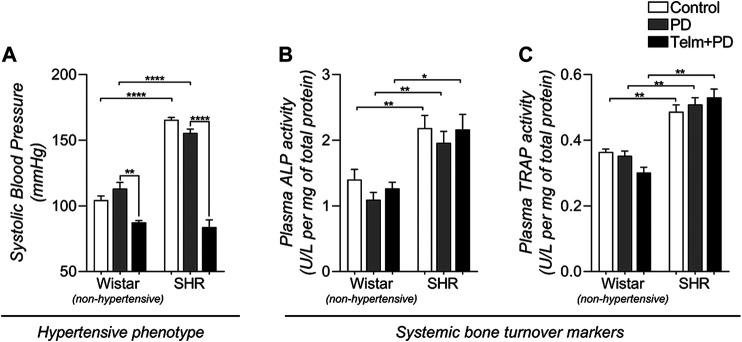
Systolic blood pressure (SBP) and systemic bone turnover biochemical markers of Wistar (non-hypertensive) and SHR with PD 15 days, treated with telmisartan. SBP (A) measured by tail plethysmography, and plasma activity of alkaline phosphatase, ALP (B) and tartrate-resistant acid phosphatase, TRAP (C) determined by enzymatic colorimetric methods. All graphs shown mean ± SEM (n = 6). Statistical difference are represented by brackets labeled by *p < 0.05, **p < 0.01, ***p < 0.001, and ****p < 0.0001, comparing Control vs. PD, PD vs. Telm + PD, and Wistar vs. SHR in the same experimental condition.